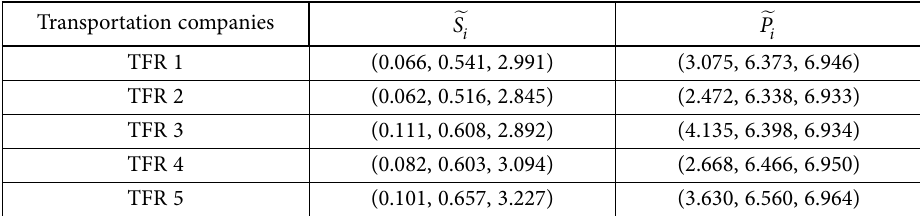
Table 13. The fuzzy sum of the weighted comparability and the power weight of the comparability sequences Transportation companies 